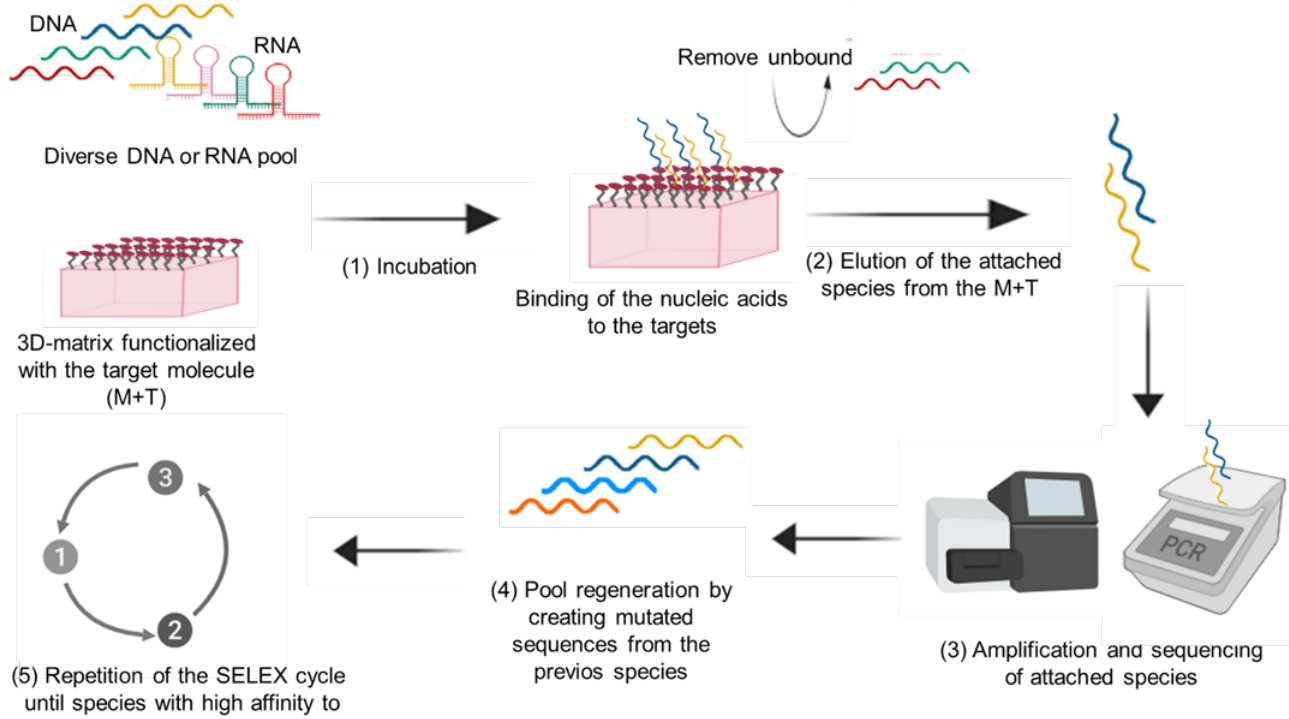
Figure 5. After synthesizing a phage library with a high affinity towards cancer cells, the phages are fluorescently labeled and incubated with the cancer cells. Later, the phage and cancer cell complex can be evaluated in flow cytometry.